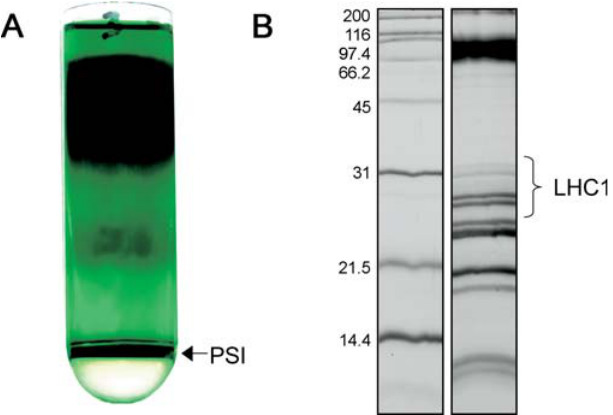
Figure 1. Isolation of PS-I by Detergent Solubilization and Density- Gradient Centrifugation (A) The final centrifugation step of the isolation protocol, the linear 0.1– 1M sucrose gradients contain 0.02% Triton X-100. The detergent- solubilized (at 0.8% v/v Triton X-100) PS-I particles selectively aggregate upon entering the low Triton X-100 concentration of the gradient and sediment quickly relative to the other thylakoid proteins that remain at the top of the gradient. (B) SDS-PAGE 18% slab gel lane containing the PS-I harvested from the 1M/2M interface as seen in (A). The region containing the LHCI is indicated. DOI: